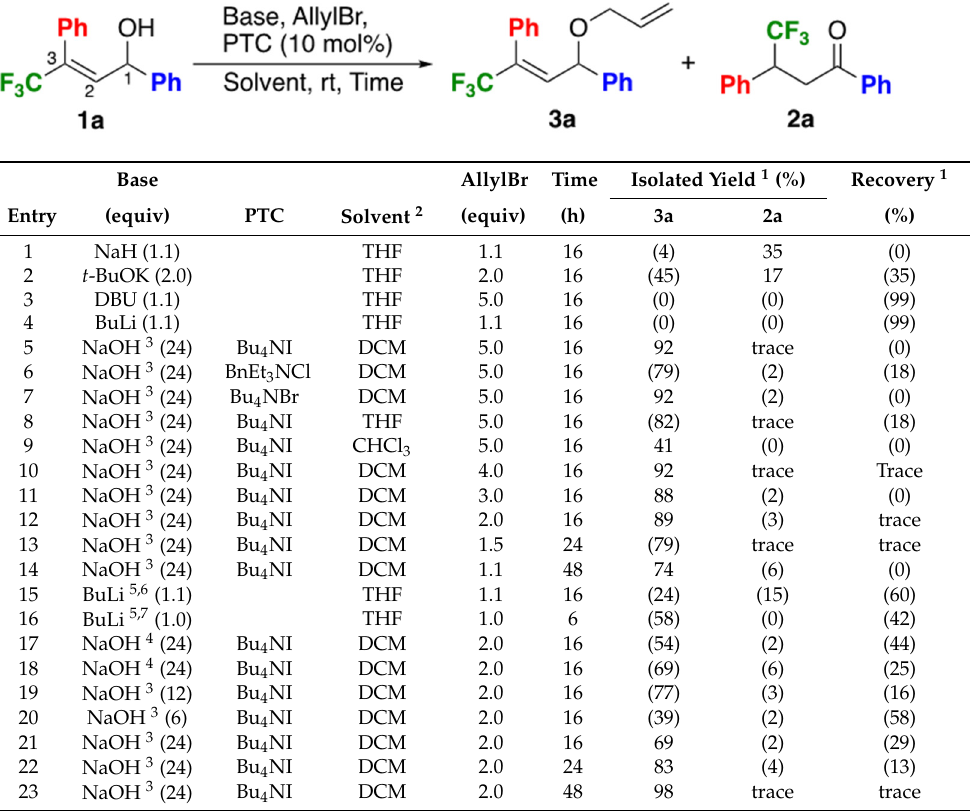
1 Yields determined by 19 F NMR were shown in parentheses. 2 THF: tetrahydrofuran, DCM: di- chloromethane. 3 A 6 M aqueous solution was used. 4 2 and 10 M aqueous solutions were used for Entries 17 and 18, respectively. 5 Alkoxide was prepared by the addition of BuLi at 0 °C for 10min, followed by changing the temperature as depicted. 6 Reaction was performed at reflux tempera- ture. 7 3.0 equiv of HMPA was